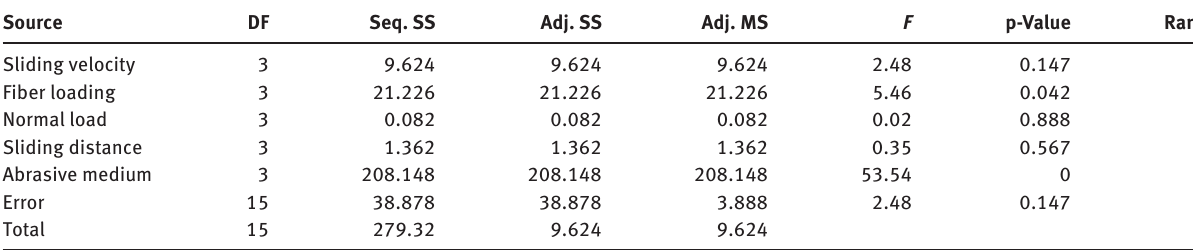
Table 4B ANOVA table for homogeneous composites for specific wear rate.